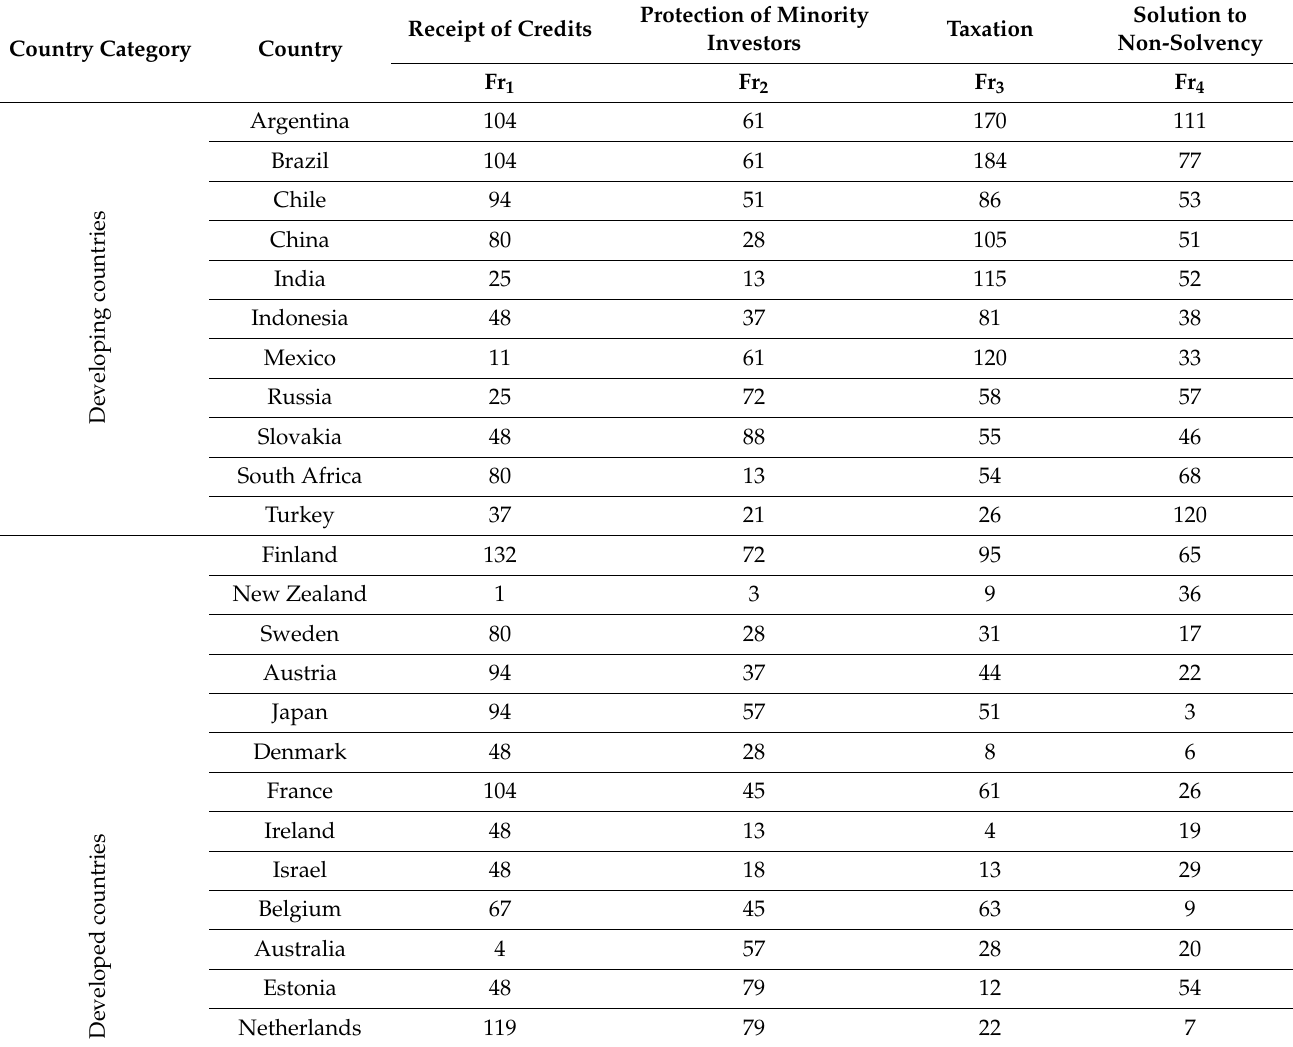
Table 1. Standard financial factors of commercial entrepreneurship in emerging economies of the sample in 2021 (as a result of 2020), position (the higher, the better). Source: Compiled by the authors based on the World Bank (2021). Protection of Minority Receipt of Credits Investors Country Category Country